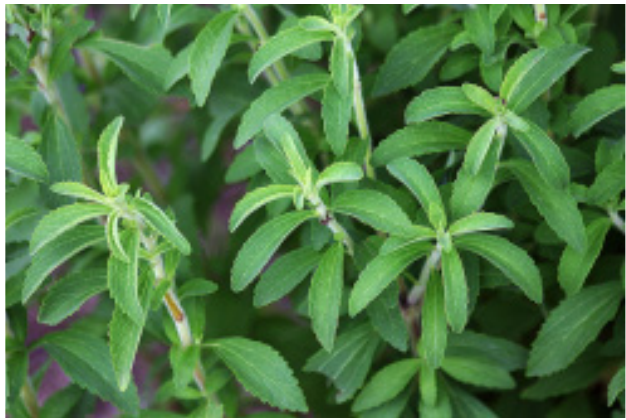
Fig. 8: Stevia rebaudiana (image by Manuel Martin Vicente, https://www. flickr.com/photos/martius/37147164031, CC BY 2.0)